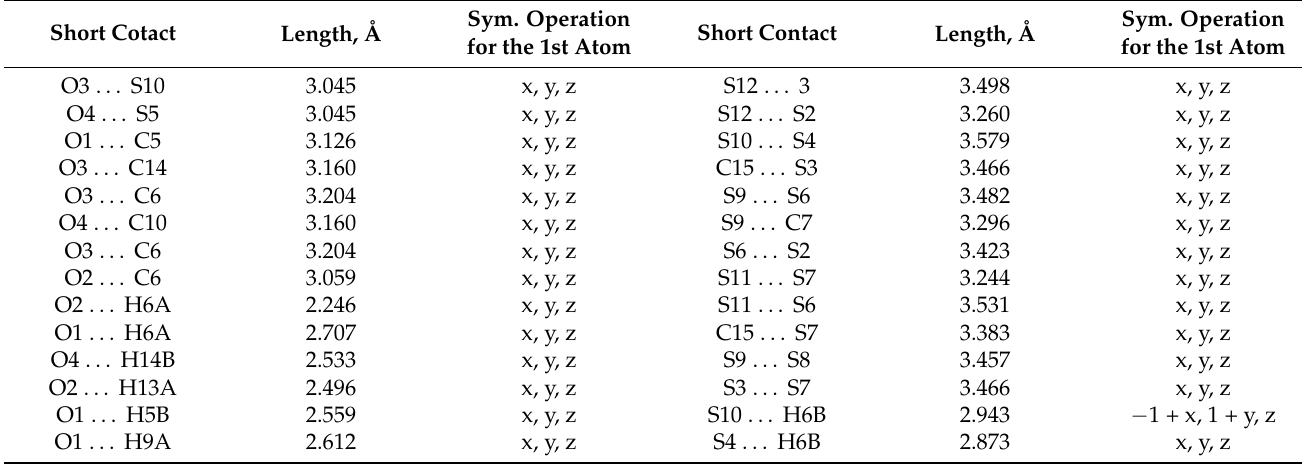
The conducting layers in 3 are built from dimers and single donor molecules (so called pseudo- κ -type packing) [5,22]. In the dimers, the radical cations are located “face-to-face” with a longitudinal shift larger than the shifts in salts 1 and 2 (Figure S6, Supplementary Materials). The pseudo- κ (cid:48) -type packing, where four single molecules surround one dimer, is described in BEDT-TTF salts [5,22]. Unlike the known BEDT-TTF salts with pseudo- κ (cid:48) - type packing [5,22], we have observed four dimers surrounding a donor molecule (new pseudo- κ ”-type packing) in 3 (Figure 6a). This type of packing of conducting organic layers has not been previously observed in radical cation salts. The dihedral angle between the single BDH-TTP molecule and dimer is 84.45 ◦ . The distances between the radical cations in dimer and between single molecules are equal to 3.289 Å and 5.374 Å, respectively. The distances along the a and b axes between the radical cations in the dimer and a single BDH- TTP molecule are 3.456 and 3.651 Å, respectively. The lengths of C=C bonds in the single radical cation and dimer are shown in Table 4. By the value of C=C bonds, one can estimate